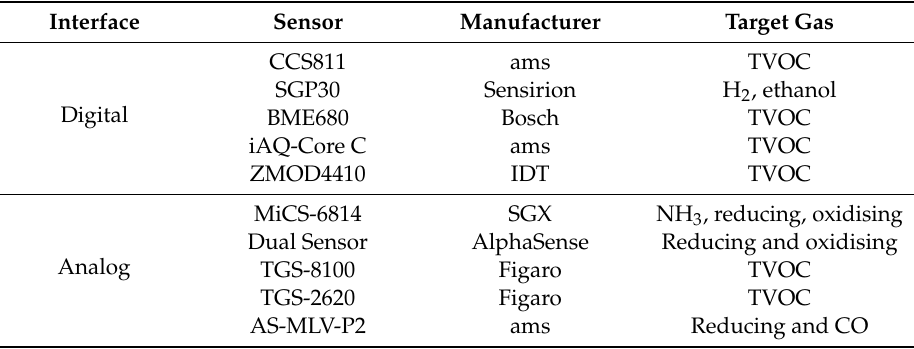
Table 1. Sensors deployed in WOLF Breath